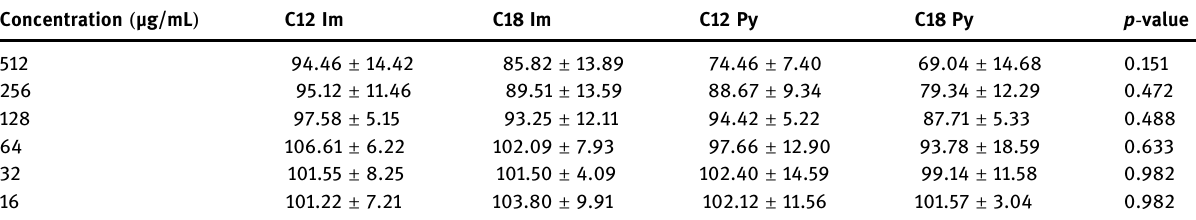
Concentration ( µg/mL